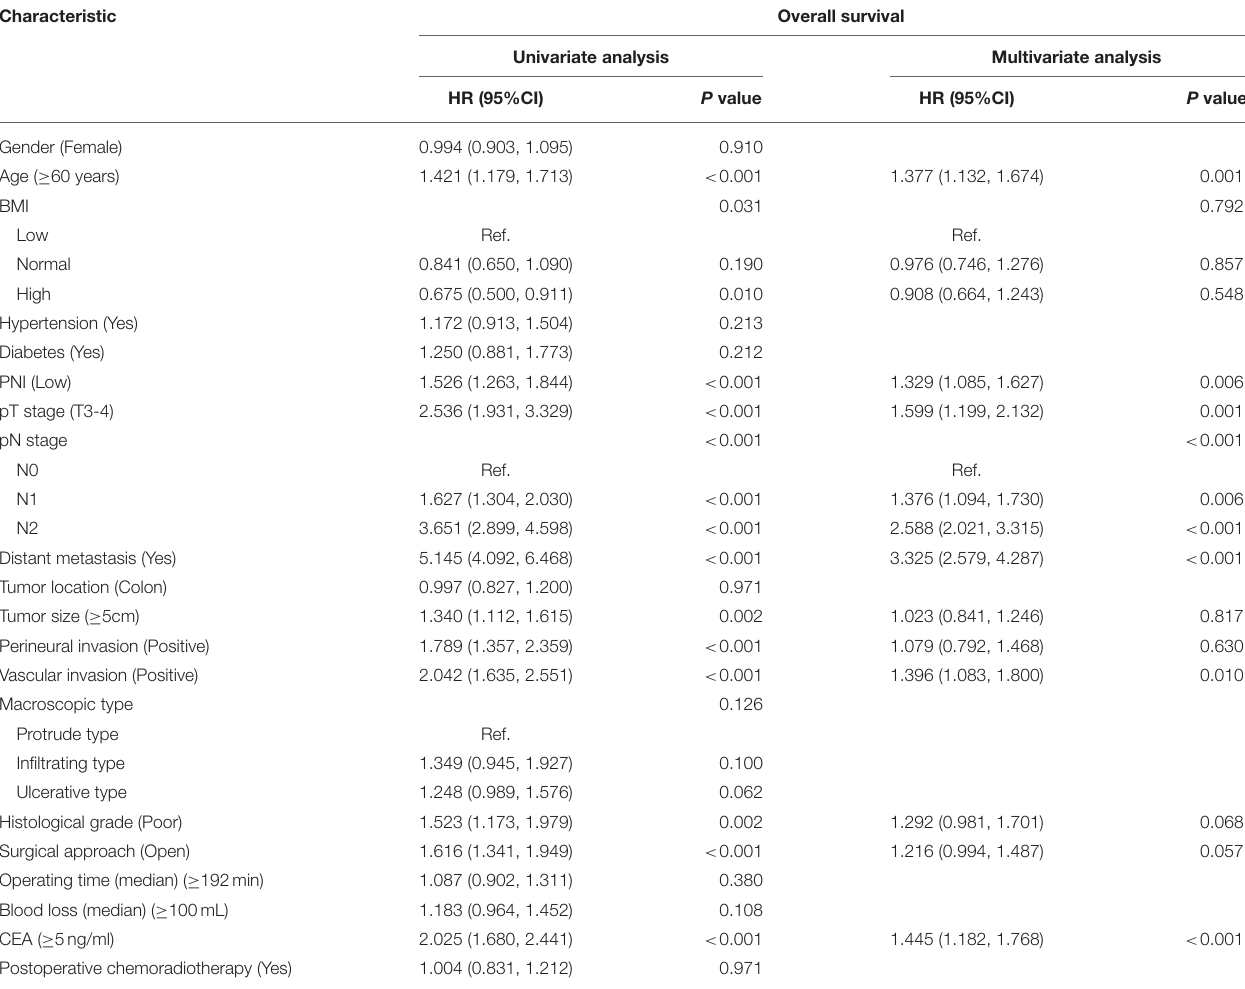
TABLE 3 | Univariate and multivariate Cox regression analysis of clinicopathological characteristics associated with overall survival. Characteristic Overall survival Univariate analysis Multivariate